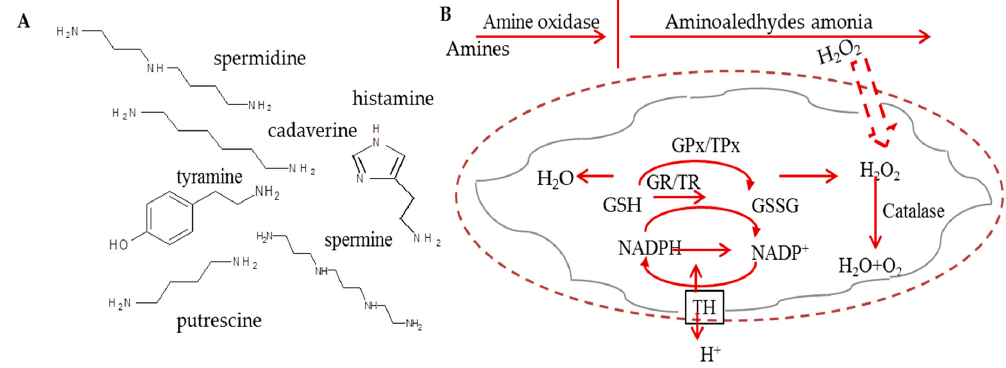
Figure 1. ( A ) The chemical structure of studied biogenic amines; ( B ) The scheme of amines oxidation in plants, their effects on damaging of membranes and defense mechanisms. H 2 O 2 can be removed by catalase and HO · by mannitol. The defense mechanism of GPx/GR and TPx/TR systems and nicotinamide nucleotide TH are also shown. In the scheme, GPx stays for glutathione peroxidase; GRx for glutathione reductase; MPT for mitochondrial permeability transition; TH for transhydrogenase; TPx for thioredoxin peroxidase; and TR for thioredoxin reductase. This scheme was inspired by Agostinelli et al. [2].